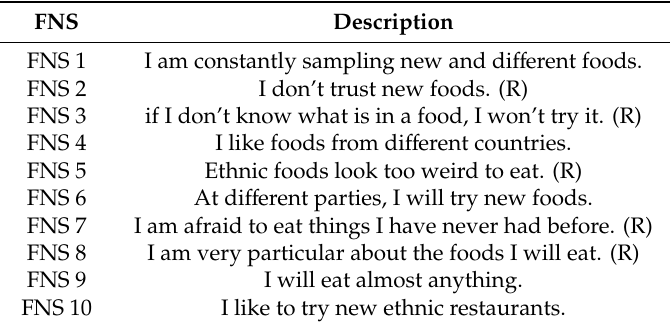
Table 3. Items used in the food neophobia scale